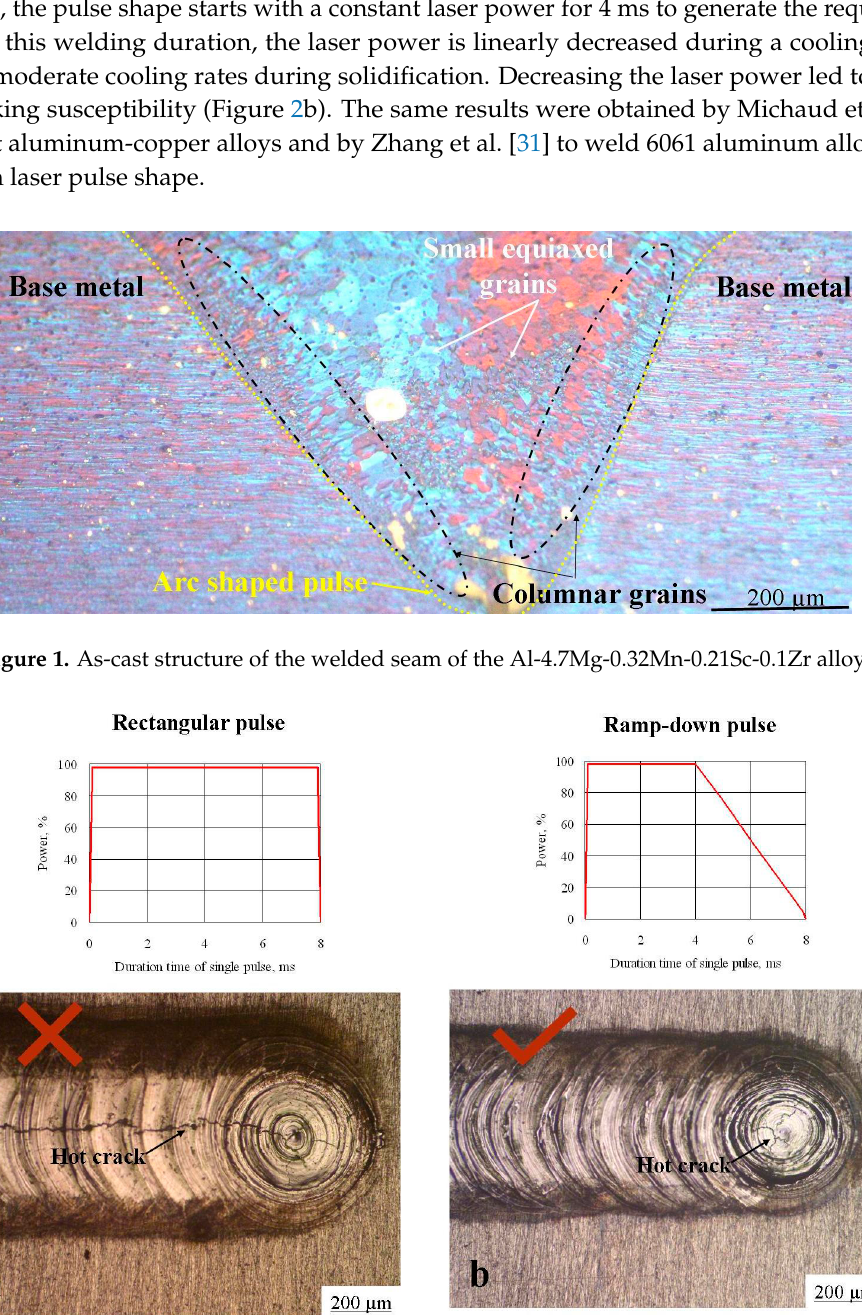
Figure 2. The effect of rectangular ( a ) and ramp-down ( b ) pulse shaping on hot cracking.